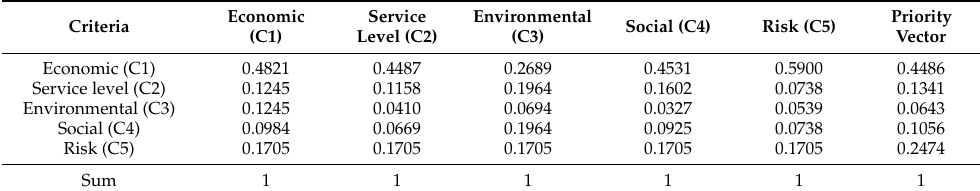
Table 8. The normalized comparison matrix of FAHP model.